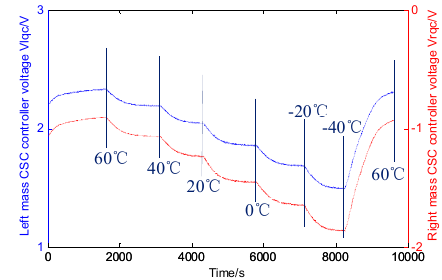
Figure 16. Full temperature range test results.